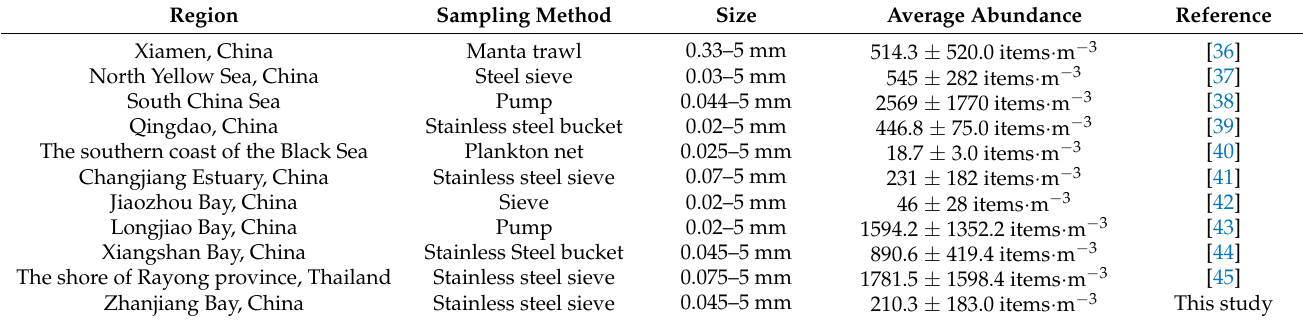
Table 1. Comparison of the abundance of MPs